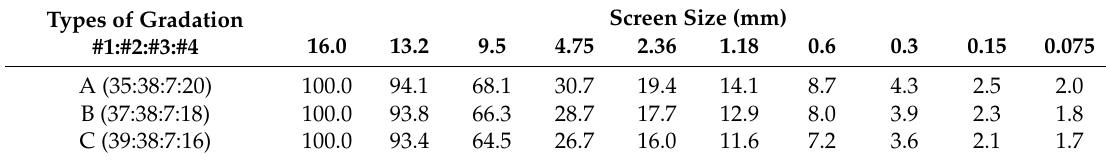
Table 10. Three grading results of the CRMB mixture.